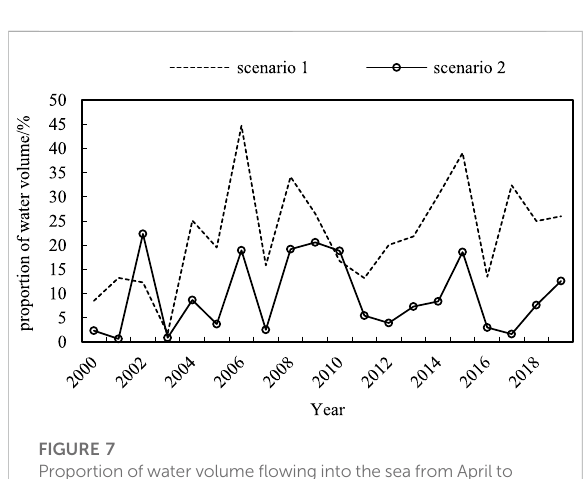
FIGURE 7 Proportion of water volume fl owing into the sea from April to June in that of the whole year in two